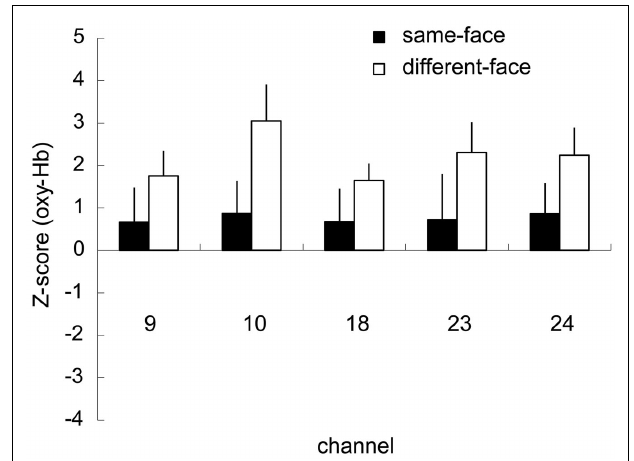
FIGURE 5 | Mean Z -scores of the five channels (ch. 9, 10, 18, 23, 24) selected as COI in the same-face and the different-face conditions, respectively. The vertical line in each graph represents 1 SE. All of these channels showed the higher Z -scores in the different-face condition compared to those in the same-face condition for oxy-Hb.The main effect of condition was significant with 2 (condition) × 5 (channel) ANOVA ( p <